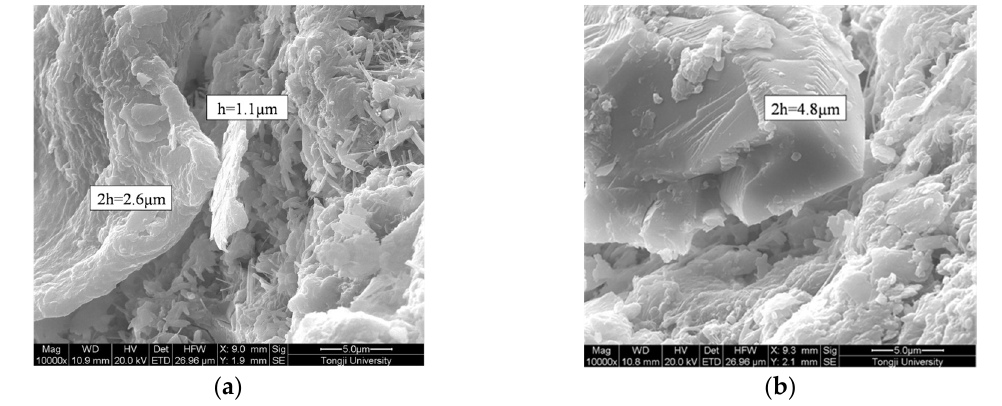
Figure 16. Measurement of microcapsule shell by SEM: ( a ) core ‐ wall ratio 1:1; ( b ) core ‐ wall ratio 1:1.25.